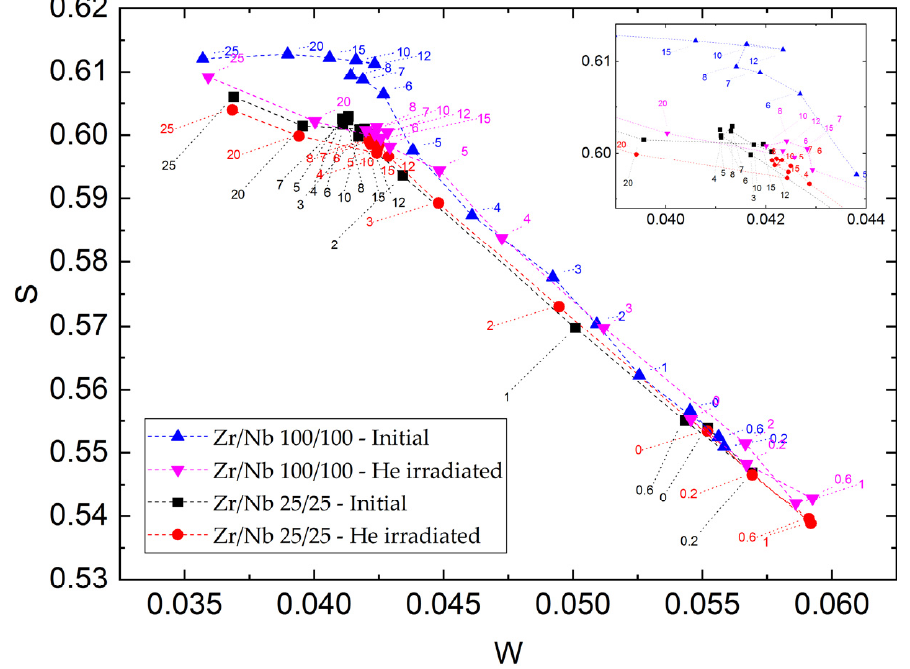
Figure 3. The S = f(W) plot for Zr/Nb NMCs at different positron energies before and after helium ion irradiation.